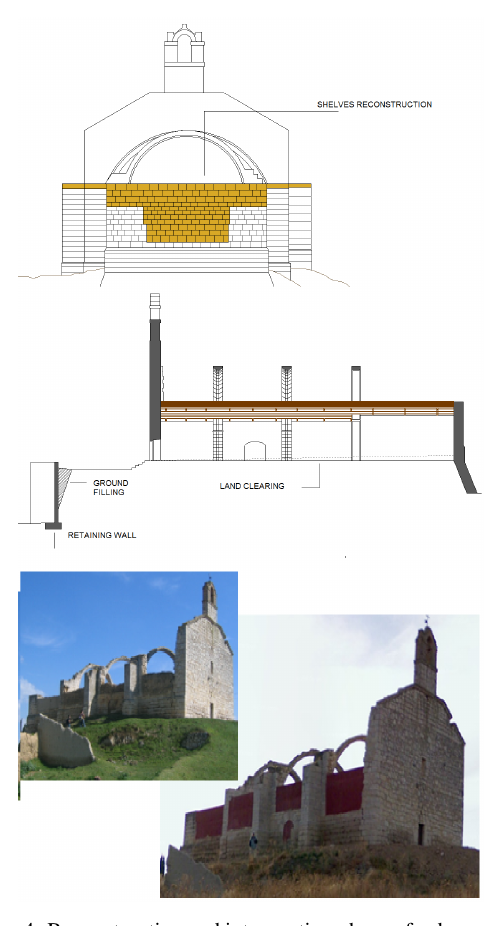
Figure 4: Reconstruction and intervention phase of a damage cul- tural heritage building.